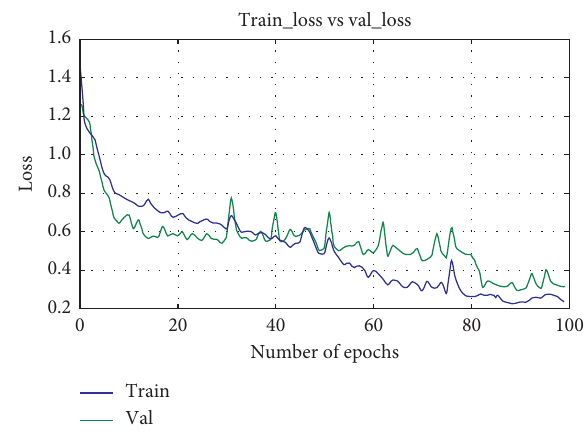
Figure 10: Training loss and validation loss of the